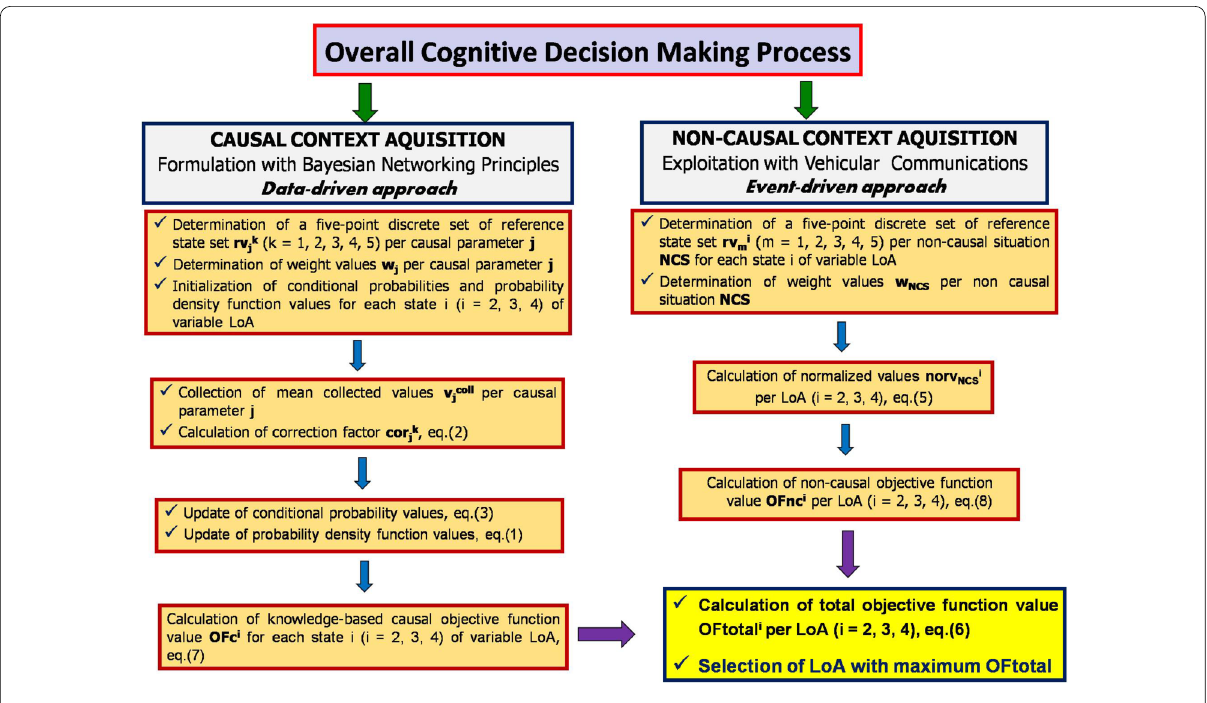
Figure 2 Proposed overall decision making process